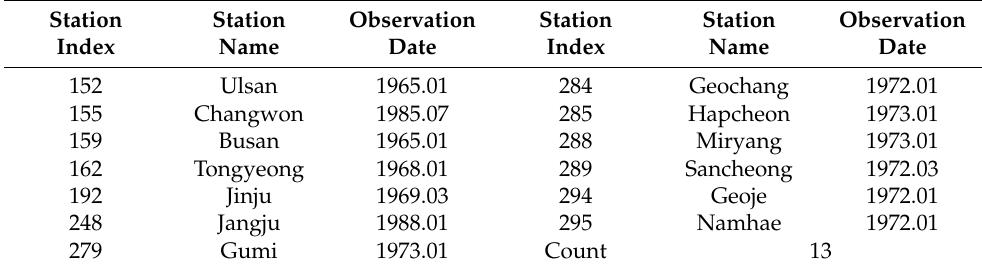
Table 3. Status of rainfall stations for Gyeongsangnamdo.